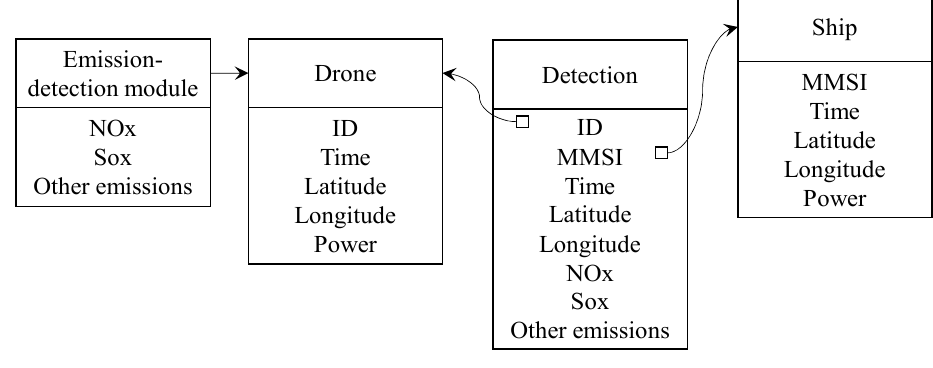
Figure 3. The data-entity model.